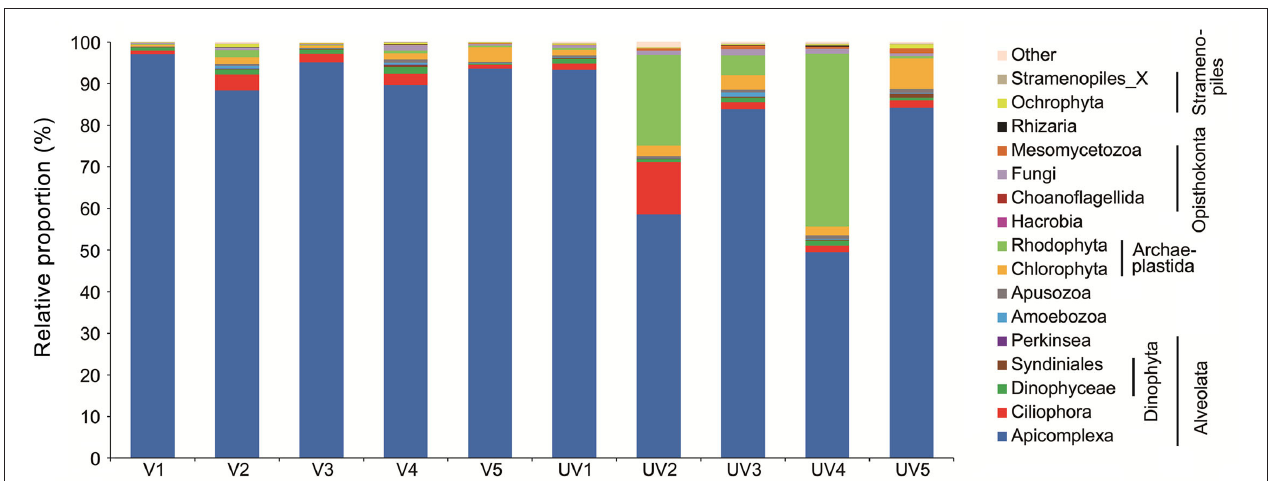
FIGURE 1 | Relative proportions of reads for benthic microbial eukaryotes across vegetated (V1–V5) and unvegetated (UV1–UV5) sites of the seagrass ecosystem.